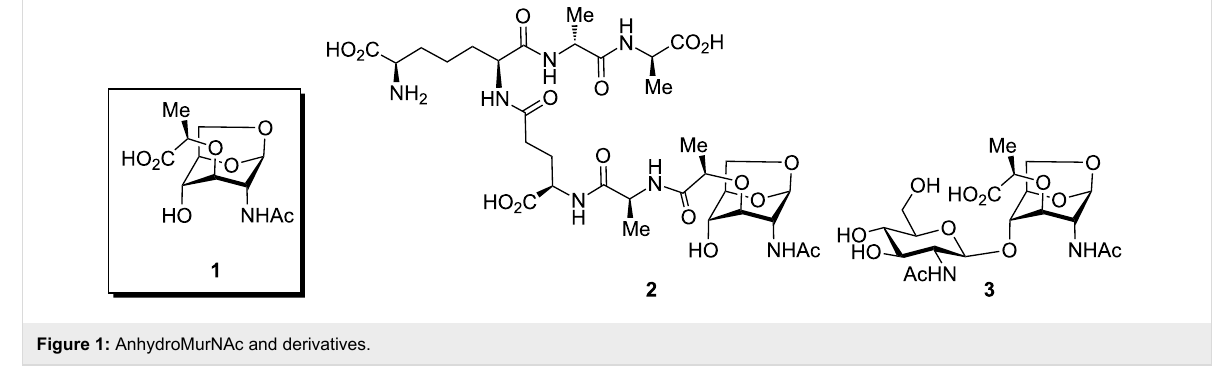
Figure 1: AnhydroMurNAc and derivatives.